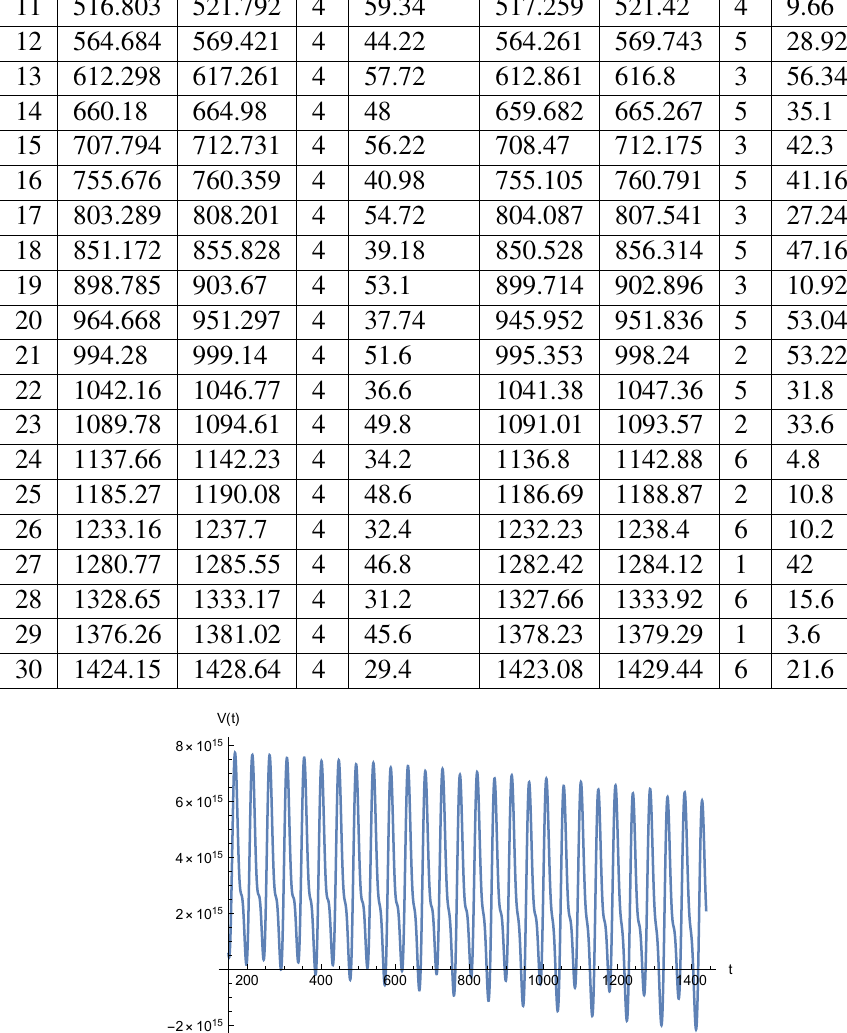
Fig. 8 Visibility Intervals Between CFESAT and MTI For 24-H Air Drag